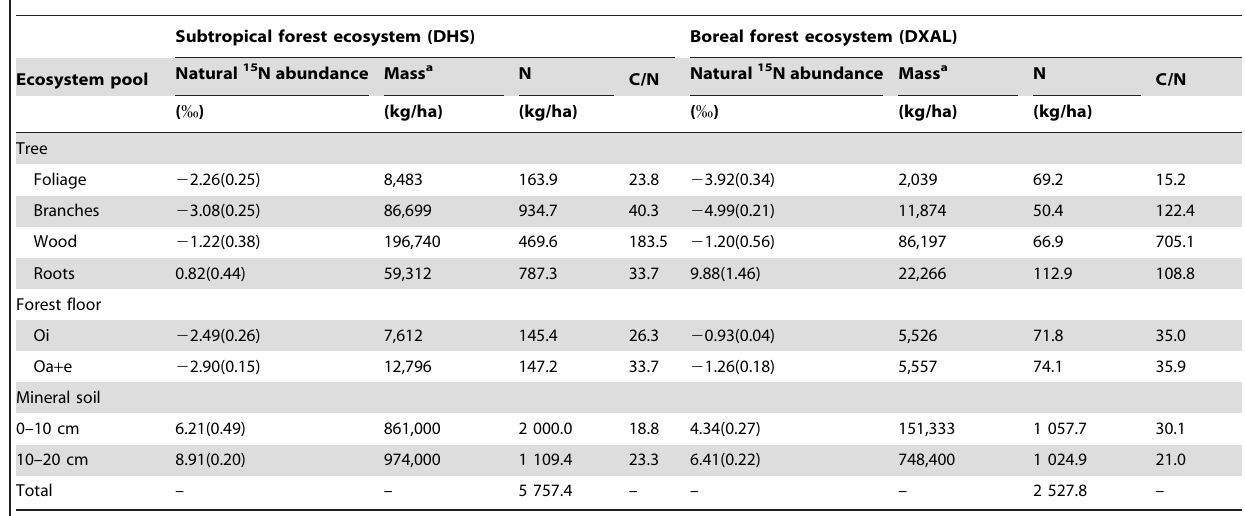
Table 2. Natural 15 N abundance and N mass in the major ecosystem pools in the two old growth forest ecosystems.